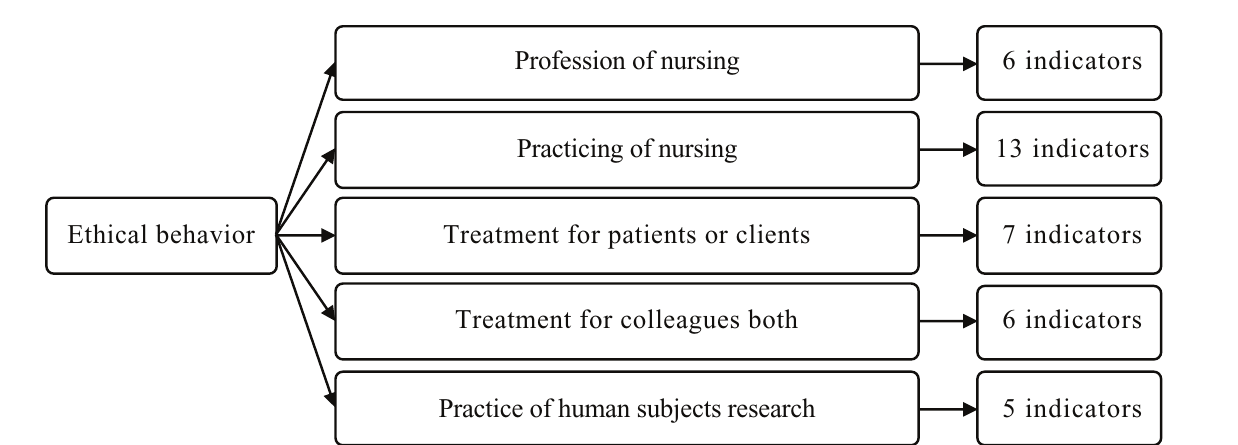
Figure 1. Hypothesized